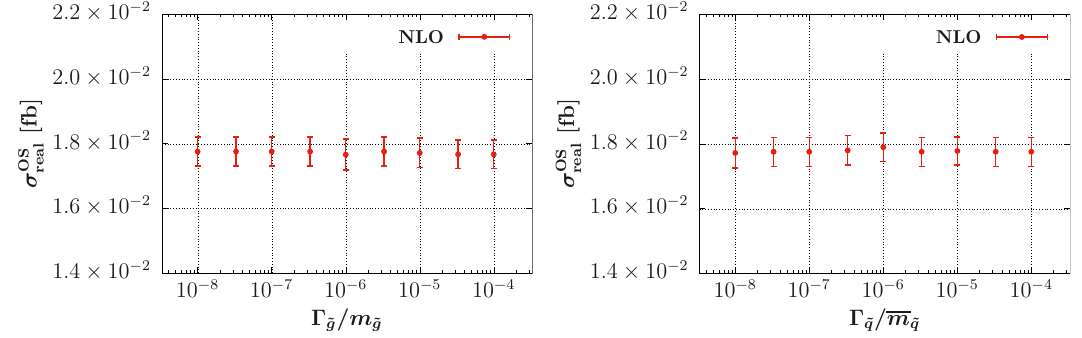
to the cross section for the process real